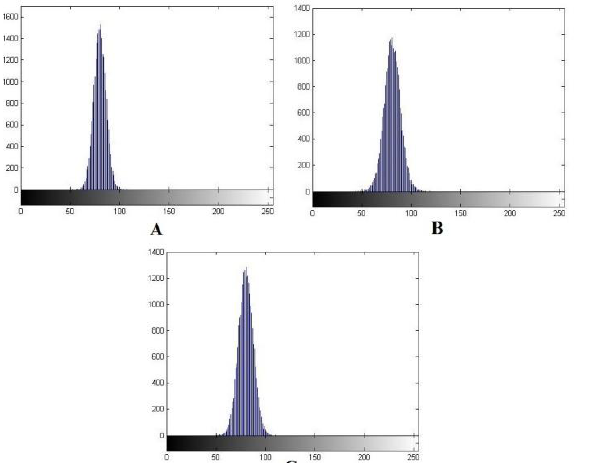
Figure 9. A) Histogram of image in Figure 7a. B) Histogram of image in Figure 7 b. C) histogram of image in Figure 7 (c).